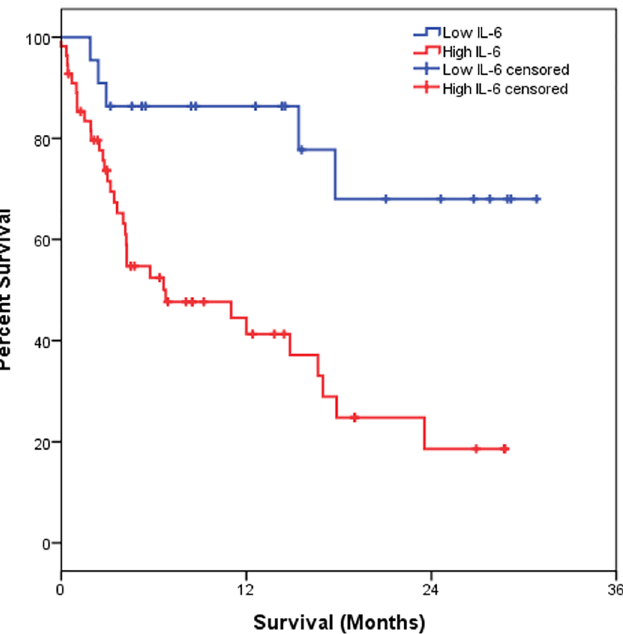
Fig 2. Kaplan-Meier survival estimatesby stratification of serum IL-6 concentration in NSCLC